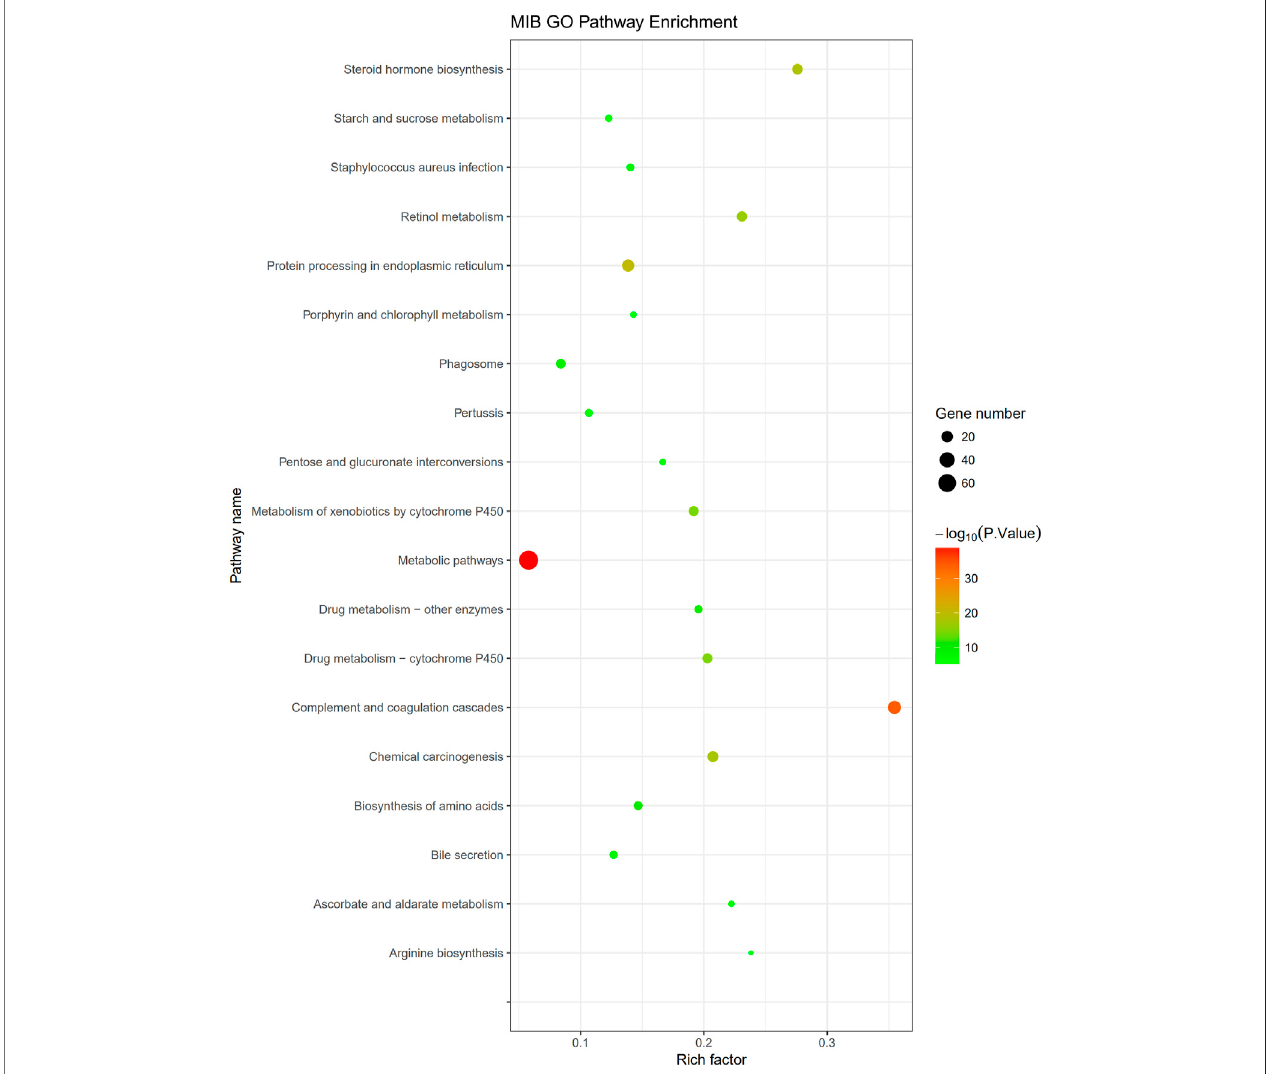
FIGURE 9 | Pathway enrichment: the vertical axis represents the name of the pathway, and the horizontal axis represents the rich factor (the ratio of the number of DEPsenrichedinthepathwaytothenumberofannotatedproteins).Thegreatertheenrichmentfactor, themoresigni fi canttheenrichmentlevelofDEPsinthispathway. Each dot in the fi gure representsa KEGG pathway, and the sizeof thedot representsthe number ofproteins enriched in the pathway. The smaller the p -value, themore reliable the enrichment signi fi cance of DEPs in this pathway.